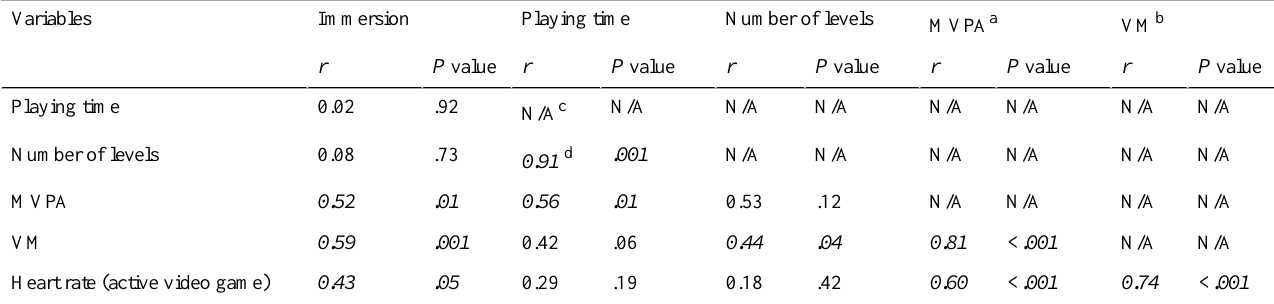
Table 3. Correlation matrix of narrative/game scales, physical activity, and heart rate.